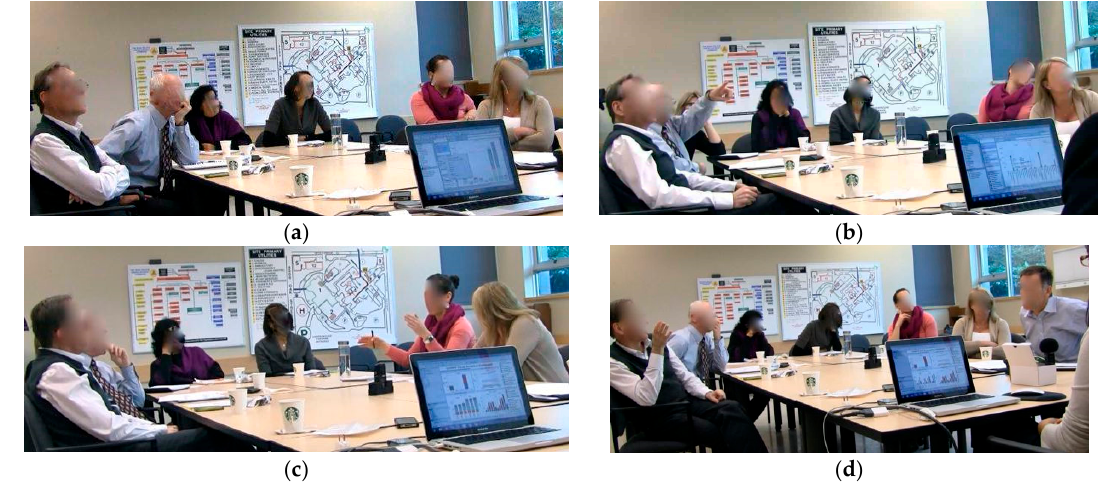
Figure 7. ( a ) Body language; ( b ) tool gestures; ( c ) hand gesture; and ( d ) body posture.